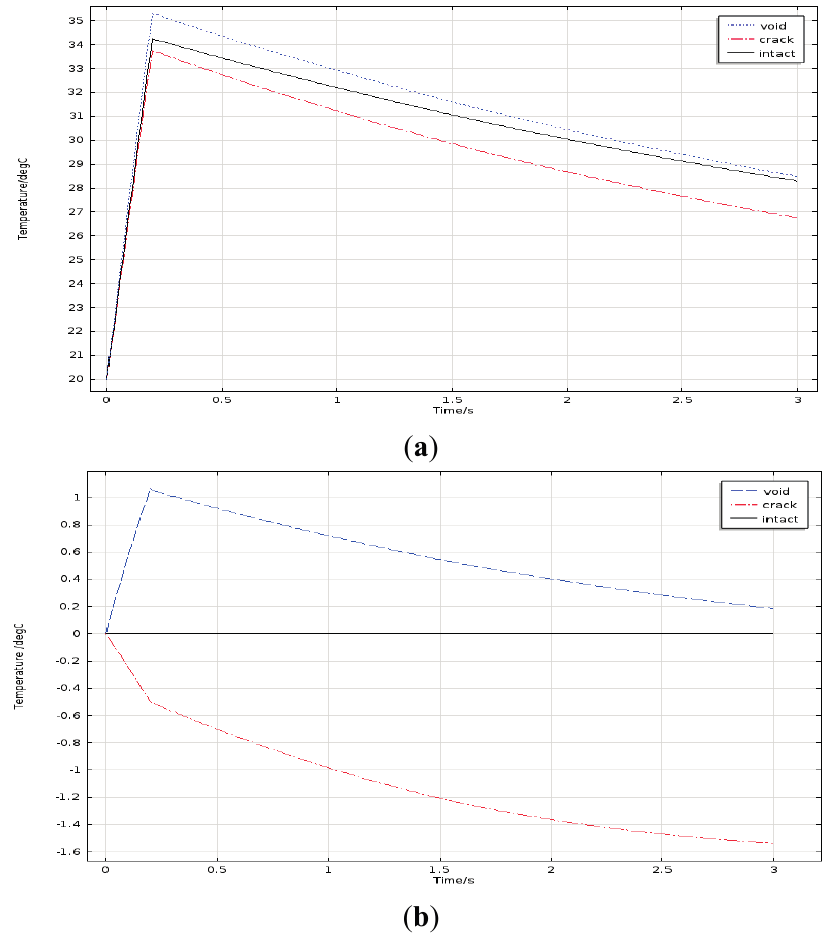
Figure 3. ( a ) Temperature curves of solder balls; ( b ) Temperature difference